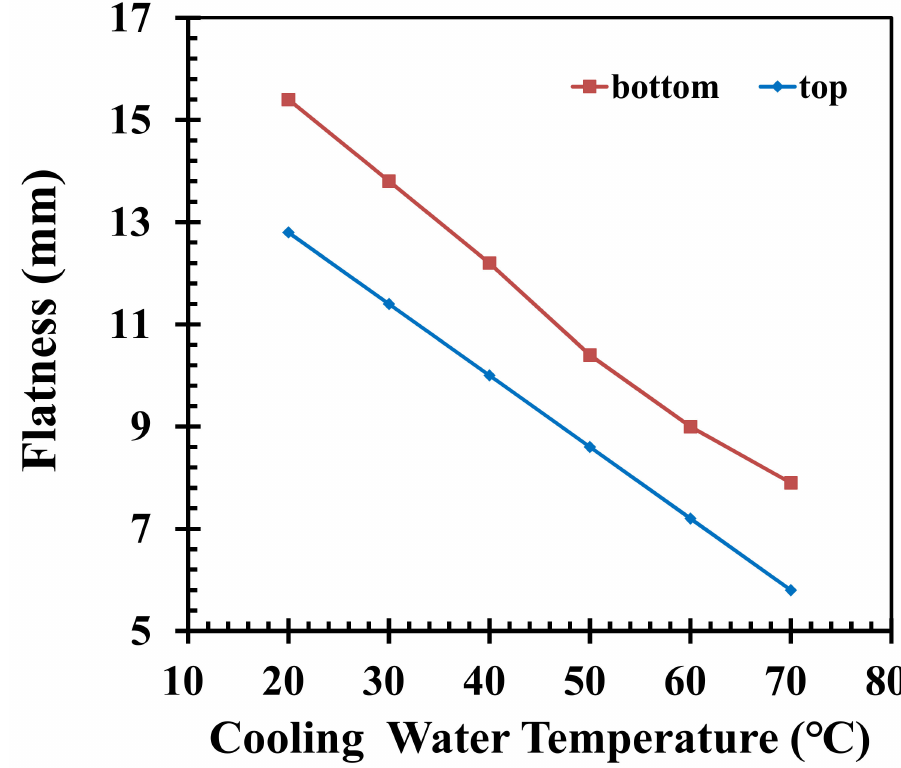
Figure 6. Influence on flatness values by adjusting the cooling water temperatures.